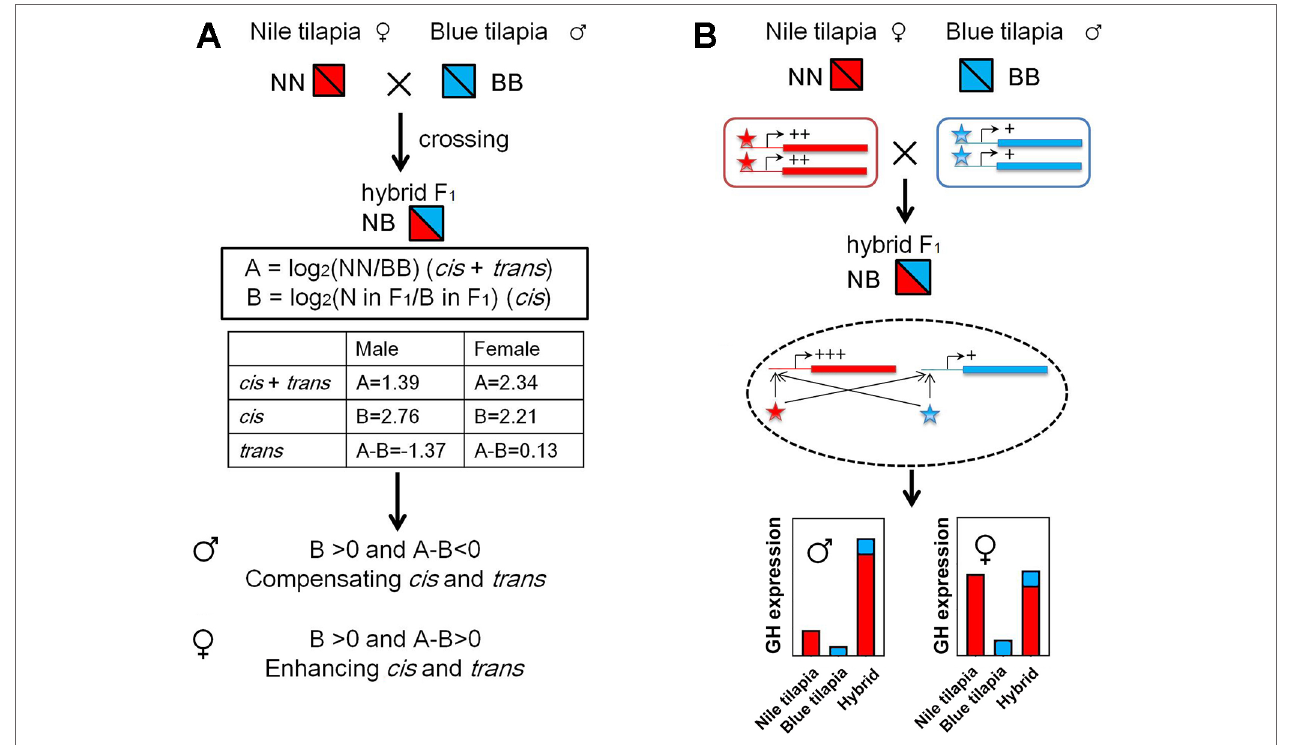
FIGURE 6 | GH cis and trans regulation in hybrid tilapia. (A) Identification of enhancing cis and trans effects was found in the hybrid by calculating the value of overall expression (data from Figure 2 ) and ASE (data from Figure 4 ). (B) Possible mode of N and B allele interactions contributes to gene expression changes in the hybrid. In hybrids, both cis and trans effects tend to increase the transcriptional activities of GH genes in the same direction. These regulations were more sensitive for the subgenome of Nile tilapia. As a result, GH in the hybrid is higher than that in its parents, while the expressions of B alleles were not changed. Nile tilapia, blue tilapia, and hybrid were represented as NN, BB, and NB, respectively. Red and blue boxes indicate genes of Nile tilapia and blue tilapia, respectively. Lines attached to the genes indicate cis elements. Asterisks indicate trans regulators (Nile tilapia in red; blue tilapia in blue). +: low expression level; ++: medium expression level; +++: high expression